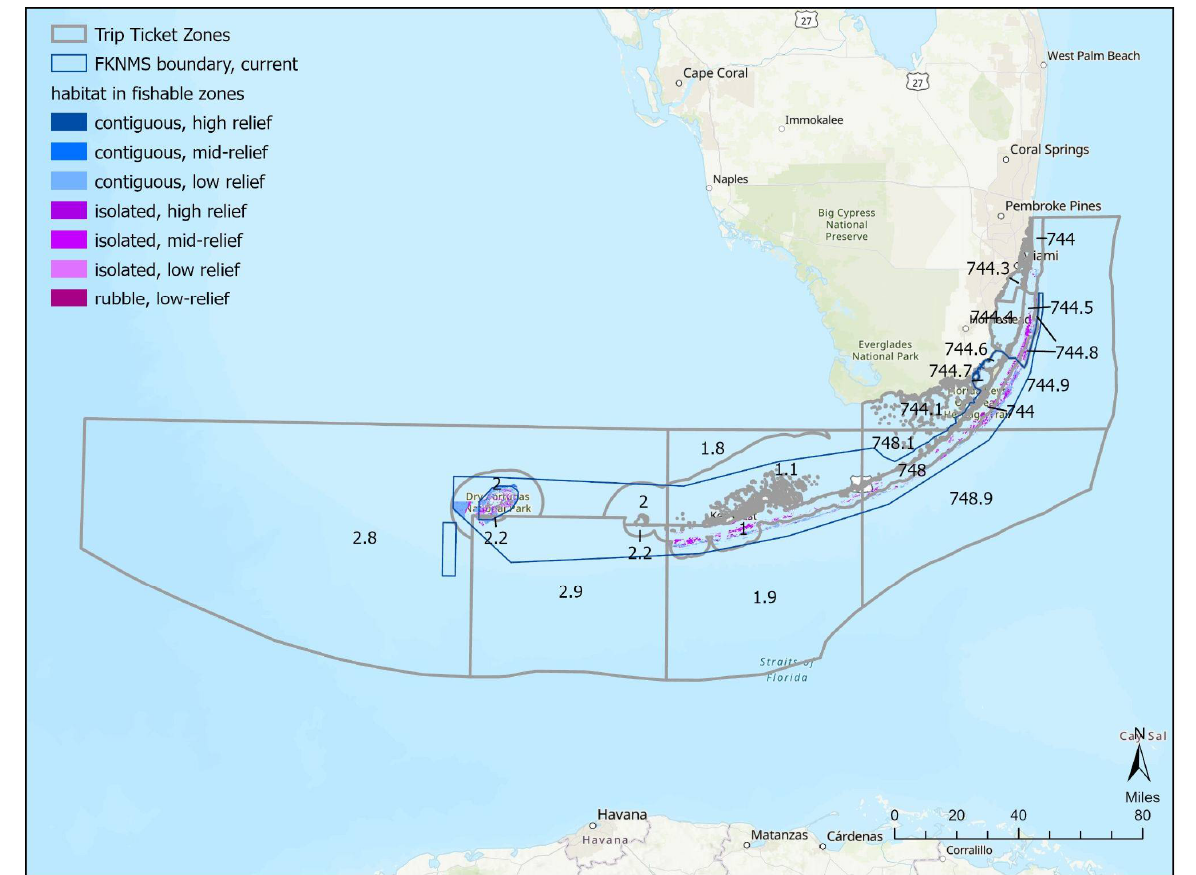
Figure 3. Trip ticket zones are layered over the outer boundary of the FKNMS and the reef tract habitat.